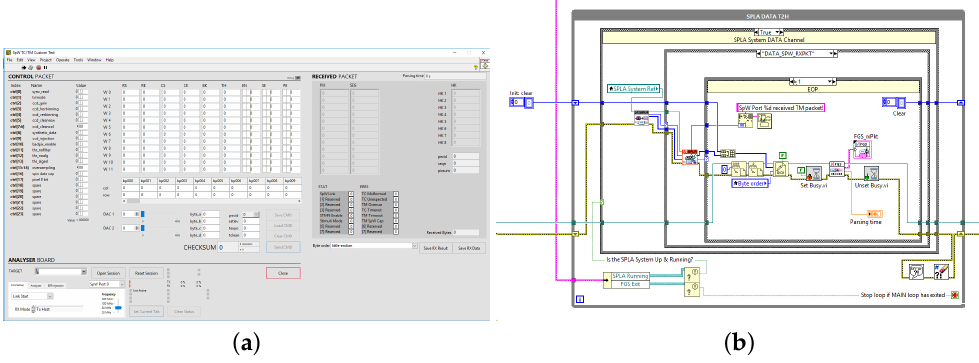
Figure 7. Real Use-Case VI. ( a ) Front-panel view and ( b ) block-diagram